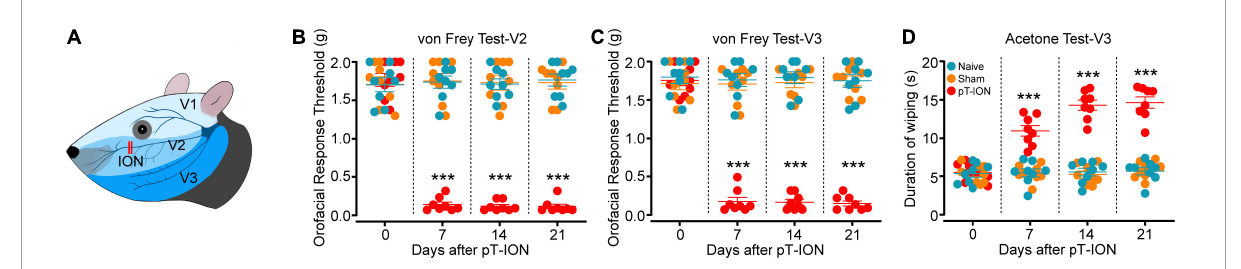
FIGURE1 Time course of pT-ION-induced orofacial allodynia. Schematic diagram of orofacial region distribution innervated by trigeminal nerve and pT-ION surgery (A) . Primary mechanical hyperalgesia in the ipsilateral facial V2 area (B) and secondary mechanical hyperalgesia in the ipsilateral facial V3 area (C) induced by pT-ION are shown as reduced thresholds to mechanical stimulation. Secondary cold allodynia in the ipsilateral facial V3 area is shown as an increased wiping duration in reaction from acetone (D) . N = 8 mice/group, *** P < 0.001 vs. naive group, two-way ANOVA and Tukey’s